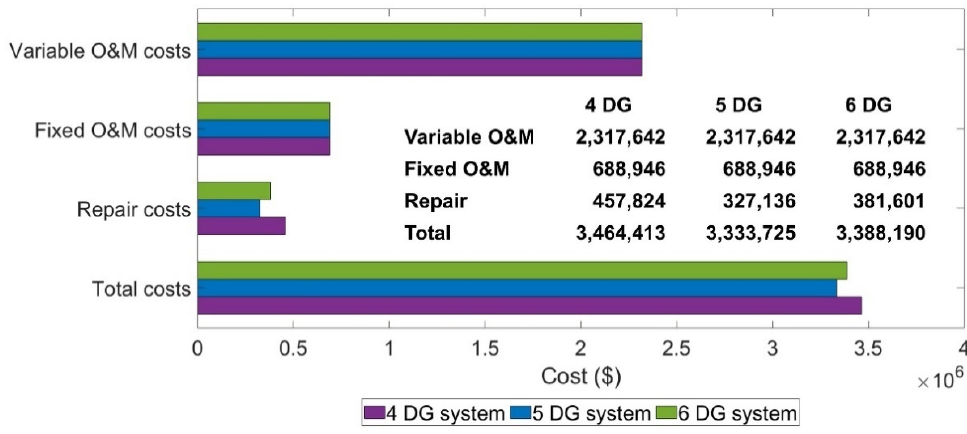
Figure 17. Extracted system MTBF of conventional configurations compared with load demands.